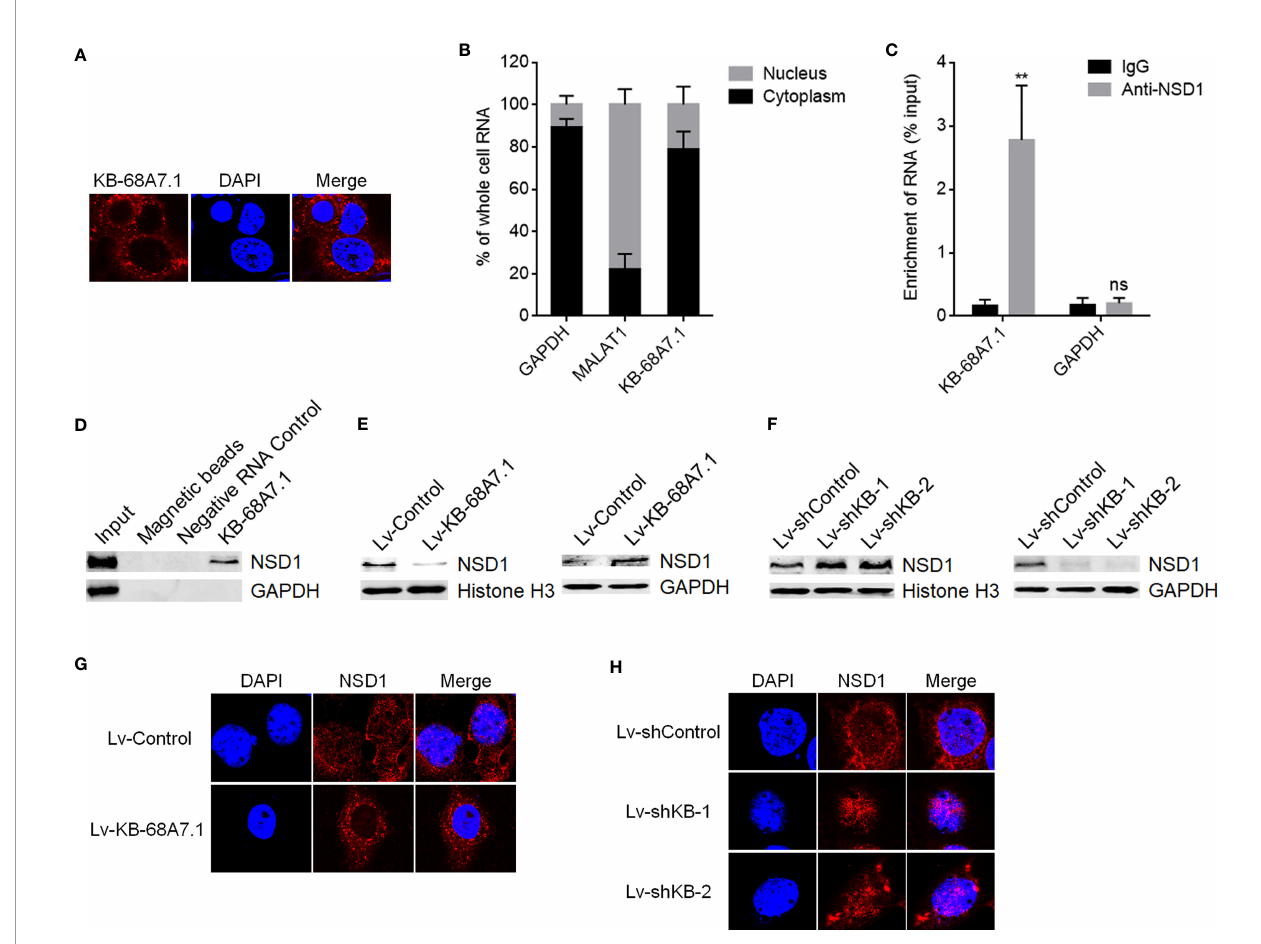
FIGURE 5 | KB-68A7.1 bound to NSD1 and redistributed NSD1 to the cytoplasm. (A) Subcellular distribution of KB-68A7.1 in SNU-398 cells was assessed by RNA FISH. (B) Subcellular distribution of KB-68A7.1 in SNU-398 cells was assessed by cytoplasmic and nuclear RNA puri fi cation, followed by RT-qPCR. GAPDH and MALAT1 were used as cytoplasmic and nuclear RNA controls, respectively. (C) RIP assays were undertaken in SNU-398 cells using NSD1 primary antibody or non-speci fi c IgG. Enrichment of RNA was assessed by RT-qPCR. (D) RNA – protein pull-down assay were undertaken in SNU-398 cells using RNA end-labeled with desthiobiotin. Enrichment of protein was assessed by Western blot. (E) Nuclear and cytoplasmic NSD1 levels in SNU-398 cells with KB-68A7.1 overexpression or control was measured by Western blot. Histone H3 and GAPDH were used as loading controls for nuclear and cytoplasmic proteins, respectively. (F) Nuclear and cytoplasmic NSD1 levels in SNU-398 cells with KB-68A7.1 silencing or control was measured by Western blot. (G) Subcellular distribution of NSD1 in SNU-398 cells with KB-68A7.1 overexpression or control was assessed by IF. (H) Subcellular distribution of NSD1 in SNU-398 cells with KB-68A7.1 silencing or control was assessed by IF. Results are shown as mean ± SD based on three independent experiments. **p < 0.01, ns, not signi fi cant by two-tailed unpaired